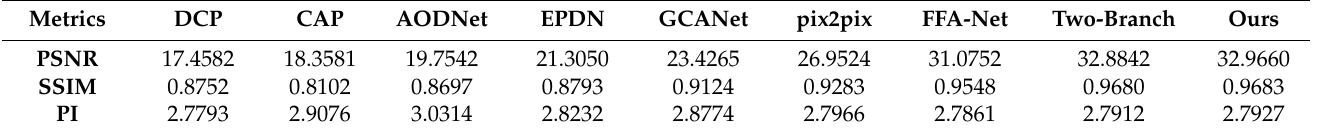
Table 1. Quantitative comparisons with other methods on synthetic